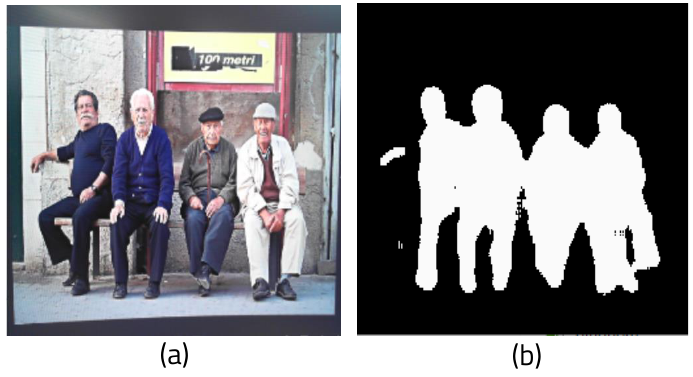
Figure 7. Results of masking: ( a ) original frame and ( b ) masked image.